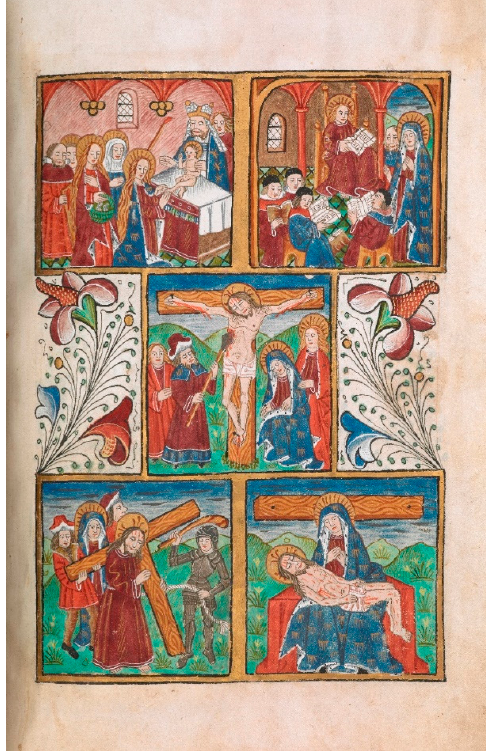
Figure 3. Pictorial cycle ahead of the Fifteen Oes in the Hours of the Earls of Ormond, f.56r, © British Library Board.